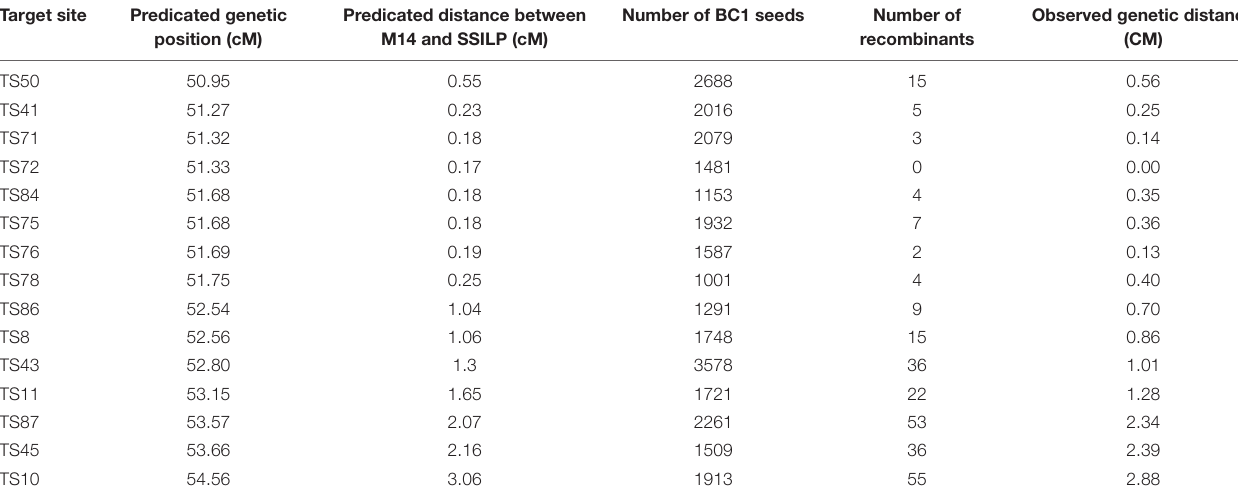
TABLE 4 | Genetic stacking of NPTII in SSILPs with PMI at the chromosomal location 51.54 cM within CTL1. Target